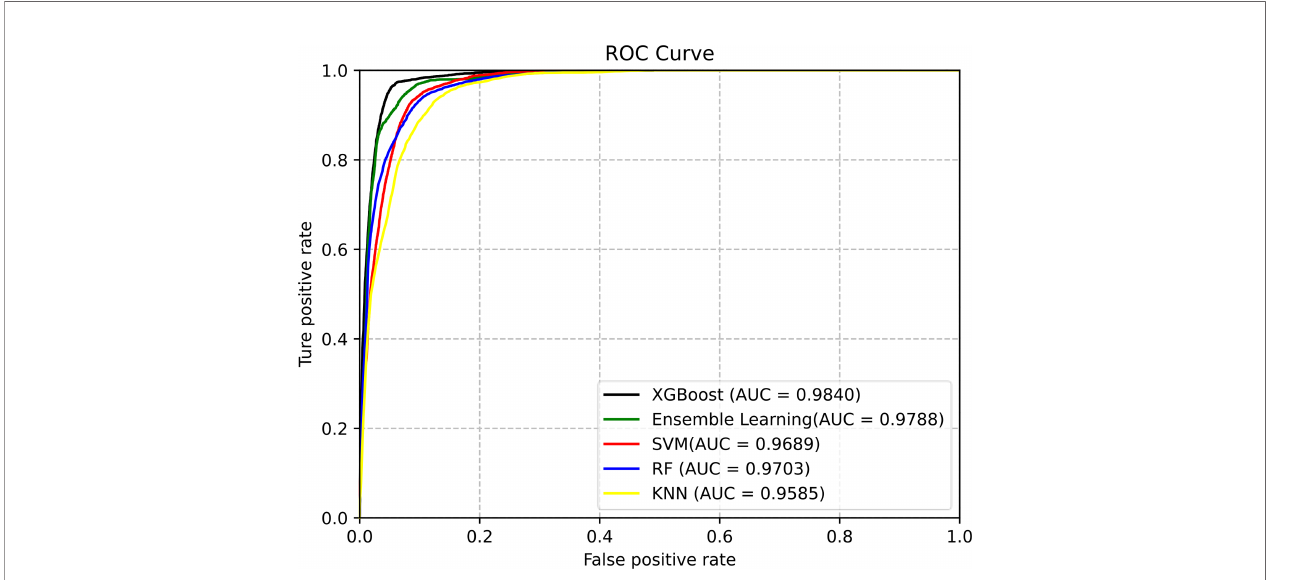
FIGURE 3 | ROC curves of different classi fi ers for predicting the pupylation protein. TABLE 4 | The prediction results of different classi fi ers on the testing set of pupylation proteins. Algorithms